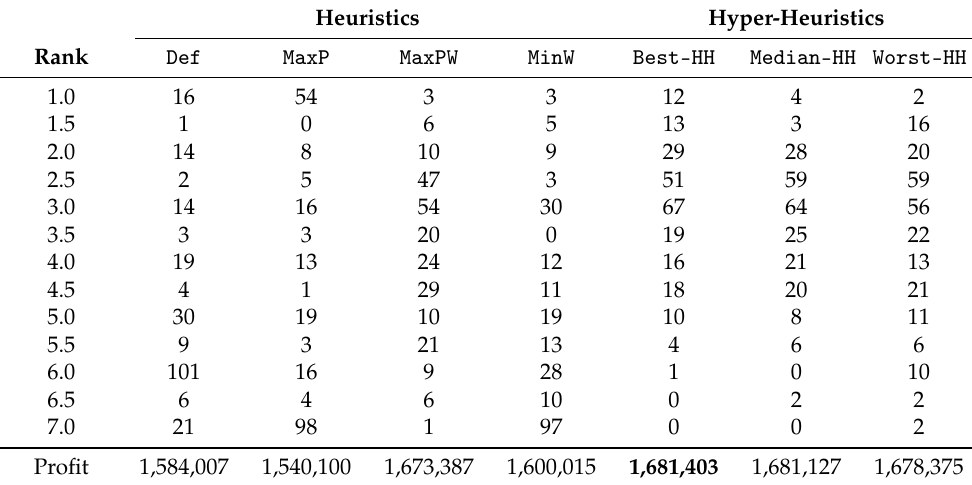
Table 8. Ranks and total profit obtained by the four heuristics and the best, median, and worst hyper-heuristics trained on 60% of set β 1 and tested on the remaining 40% of set β 1 . The best result, measured in terms of total profit, is highlighted in